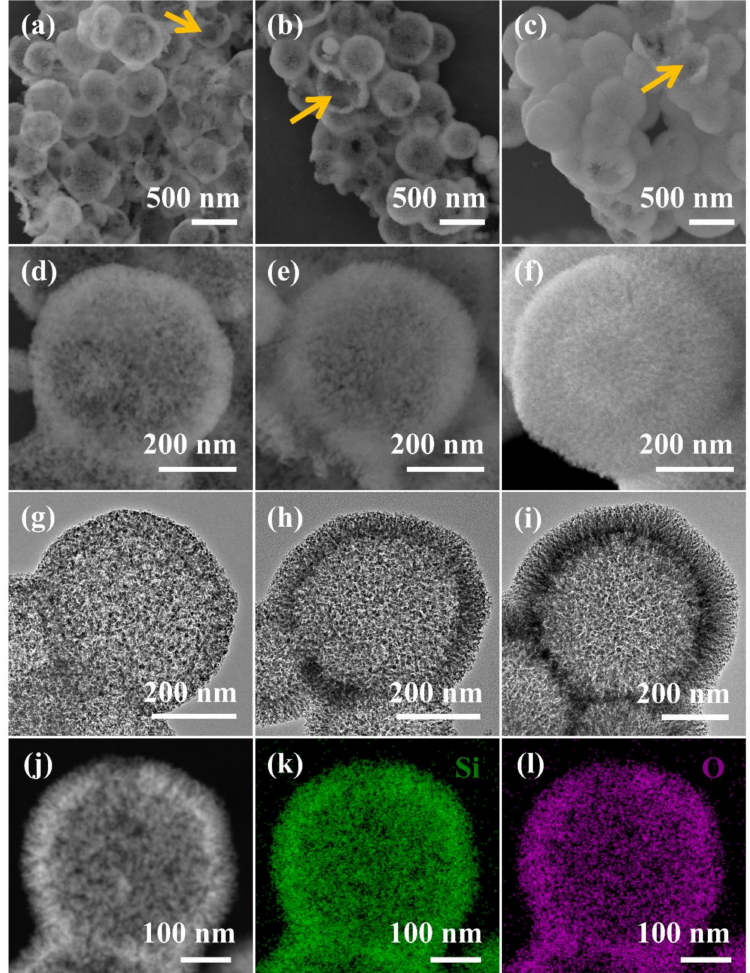
Figure 3. Scanning electron microscopy (SEM) images ( a – f ) at different magnifications and TEM images ( g – i ) of HMSN-0.55 ( a , d , g ), HMSN-1.1 ( b , e , h ), and HMSN-2.2( c , f , i ), respectively. High angle angular dark field-scanning transmission electron microscopy (HAADF-STEM) image ( j ) and energy dispersive X-ray (EDX) element mappings ( k , l ) of HMSN-1.1. The orange arrows in ( a – c ) point to hollow cavity in the fragmentized